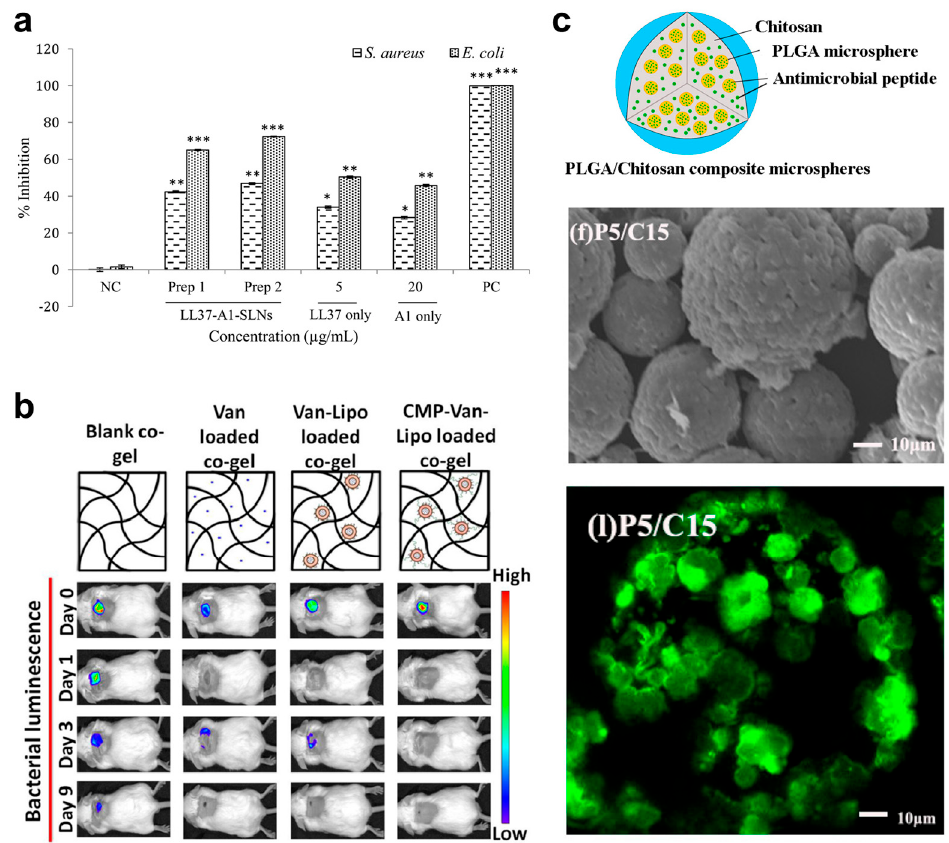
Figure 13. ( a ) Antibacterial activity of LL-37 and Serpin A1 towards S. aureus and E. coli enhanced by incorporation within a lipid carrier. Adapted with permission from [194]. Copyright 2016 American Chemical Society. ( b ) Enhanced in vivo antimicrobial activity of liposomal-vancomycin formulations encapsulated within a macroscopic collagen/fibrin gel (CMP). Reprinted from [195] with permission from Elsevier. ( c ) Schematic (top), SEM (middle), and fluorescence (bottom) images of composite microsphere scaffolds loaded with the antimicrobial peptide KSL-W. Image adapted from [199] under the Creative Commons Attribution 4.0 International License http://creativecommons.org/licenses/by/4.0/.